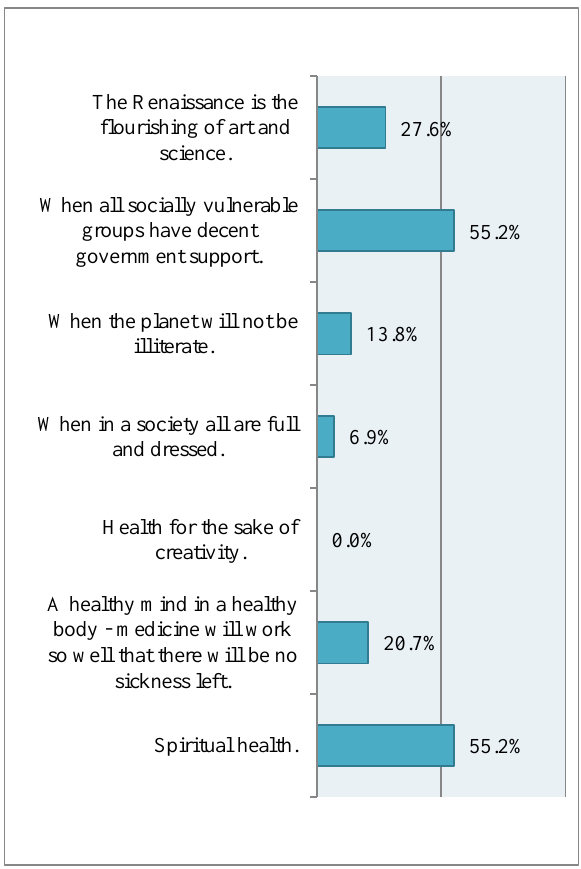
Fig. 1. Associations of graduate students with the concept of humanism.